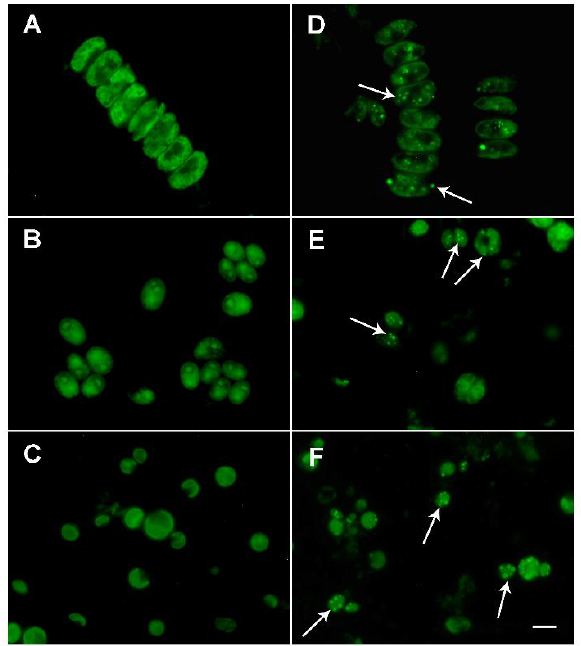
Figure 7. Fluorescence microphotographs after Fluo-4 staining of Desmodesmus quadricauda ( A , D ), Chlamydomonas reinhardtii ( B , E ) and Parachlorella kessleri ( C , F ) grown in the absence ( A – C ) or in the presence ( D – F ) of 0.1% red mud. Intracellular localization of lanthanides inside the red mud-treated cell are seen as small bright-green bodies, some of them indicated by arrows. The scale bar is 10 µ